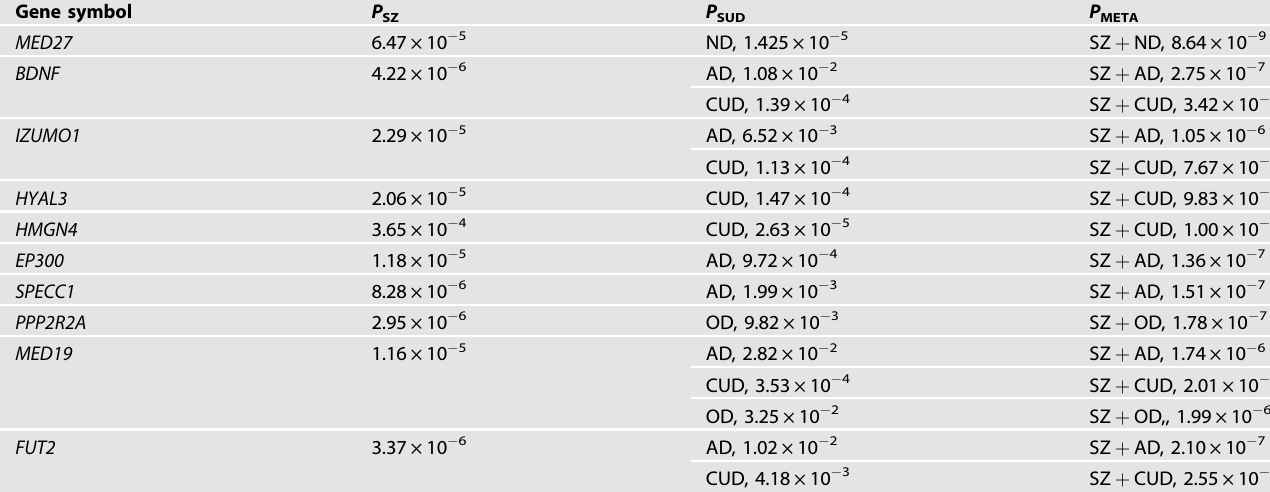
Table 1. The top ten signi fi cantly associated genes observed in the schizophrenia and substance dependence (AD, CUD, ND, and OD) MAGMA meta- analyses that were nominally signi fi cant ( P < 0.05) in the individual GWAS but did not pass multiple-testing corrections. Gene